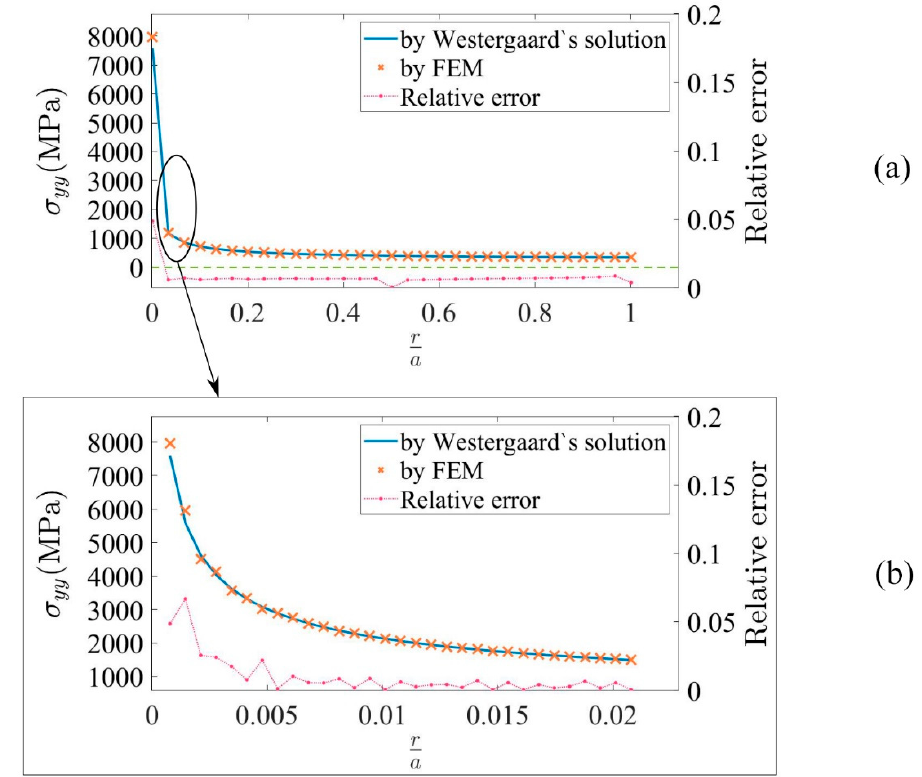
Figure 11. ( a ) Comparison between σ yy from the numerical result and Westergaard’s solution when 0 < r ≤ 1 . The relative error in the plot has no unit. ( b ) A magnified view revealing the comparison between σ yy from the numerical result and Westergaard’s solution when 0 < r ≤ 0.02 . The relative error in the plot has no unit.